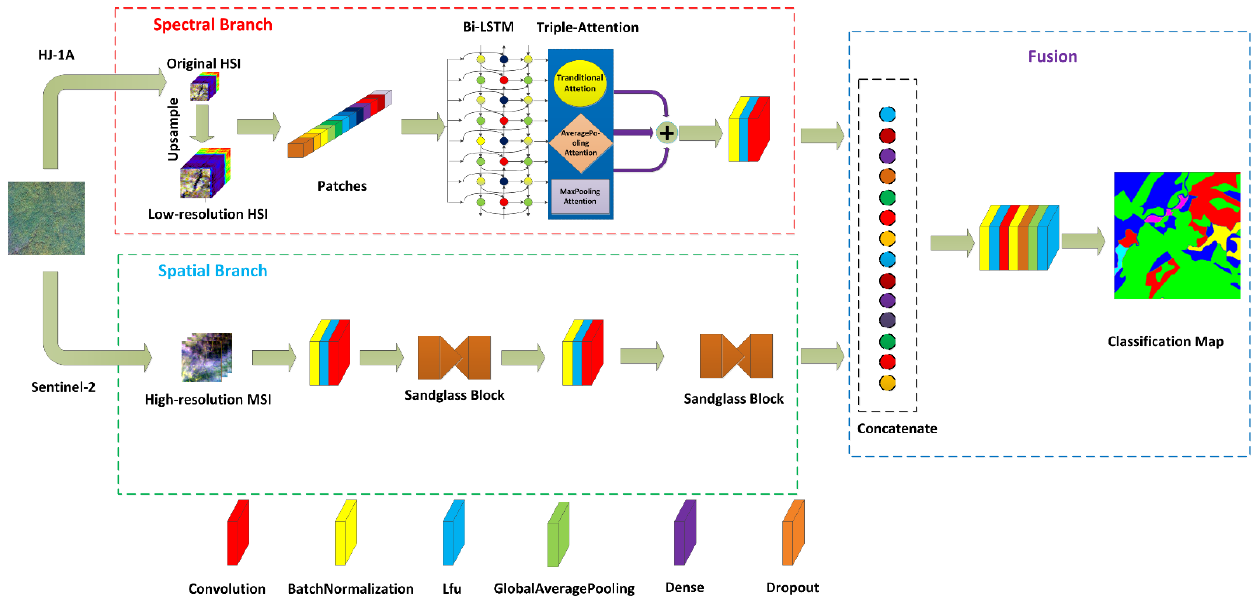
Figure 3. Architecture of the proposed DBMF method. The red dotted branch of the network employs the expected bands grouped by Bi- LSTM and the triple-attention model to extract spectral characteristics. The green dotted branch of the network employs the convolution and sandglass block to extract spatial characteristics. In the right architecture, the spectral information and spatial information are combined to form a new layer for spectral-spatial classification. The details of the spa- tial branch are similar with the spectral branch, which is shown in Table 1. The layer is a basic structure composed of a BN and Mish activation function plus a 3D-CNN with a kernel size of (3 × 3 × 1) and 24 channels. A sandglass block is applied to the network to